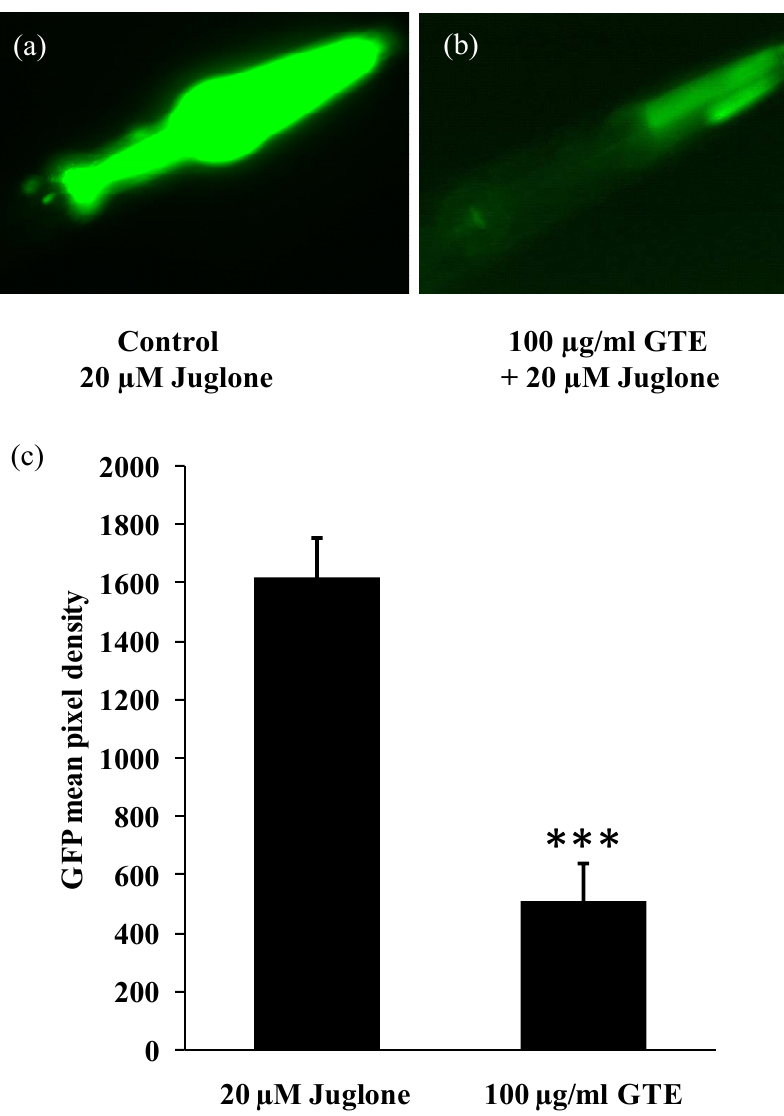
Figure 4. C . elegans strain TJ375 ( hsp-16 . 2/GFP ) visualizes the induction of